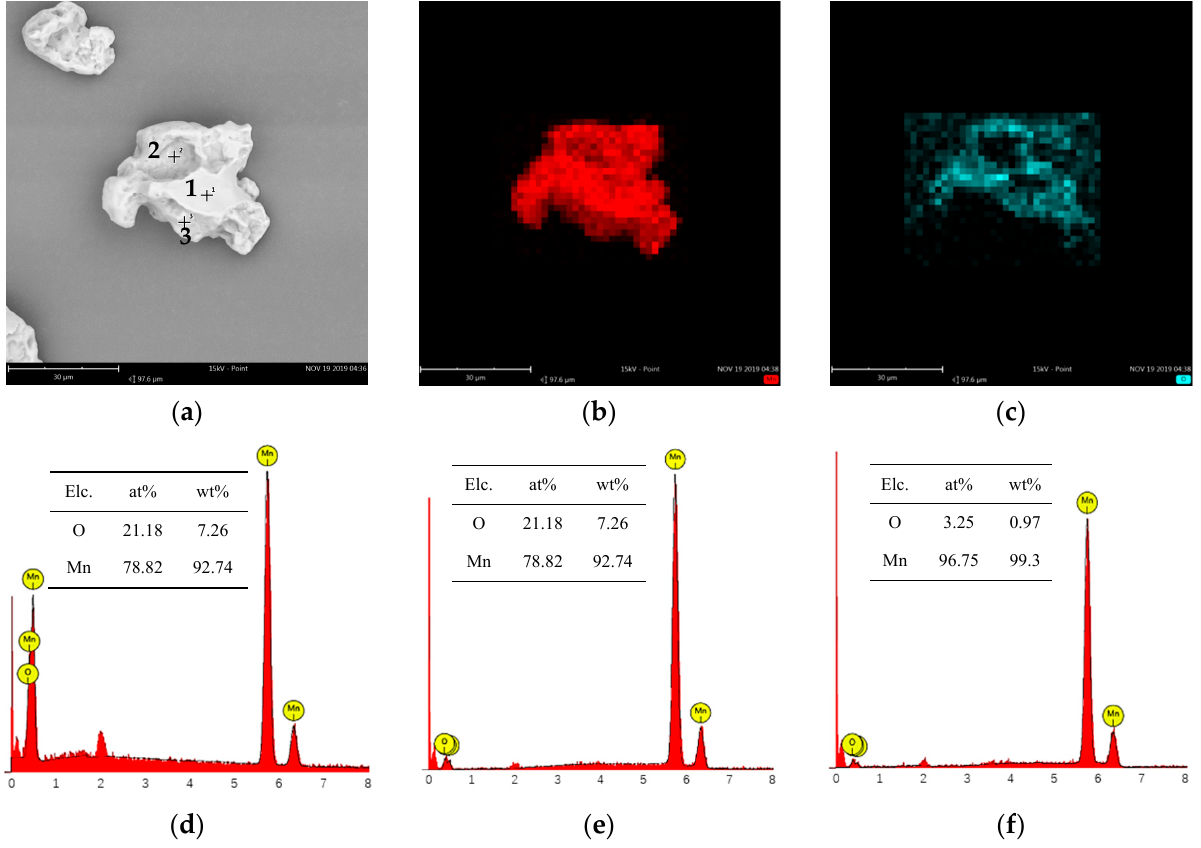
Figure 12. XRD of electro-deoxygenated products (3 V, 12 h) after cleaning at different tempera-